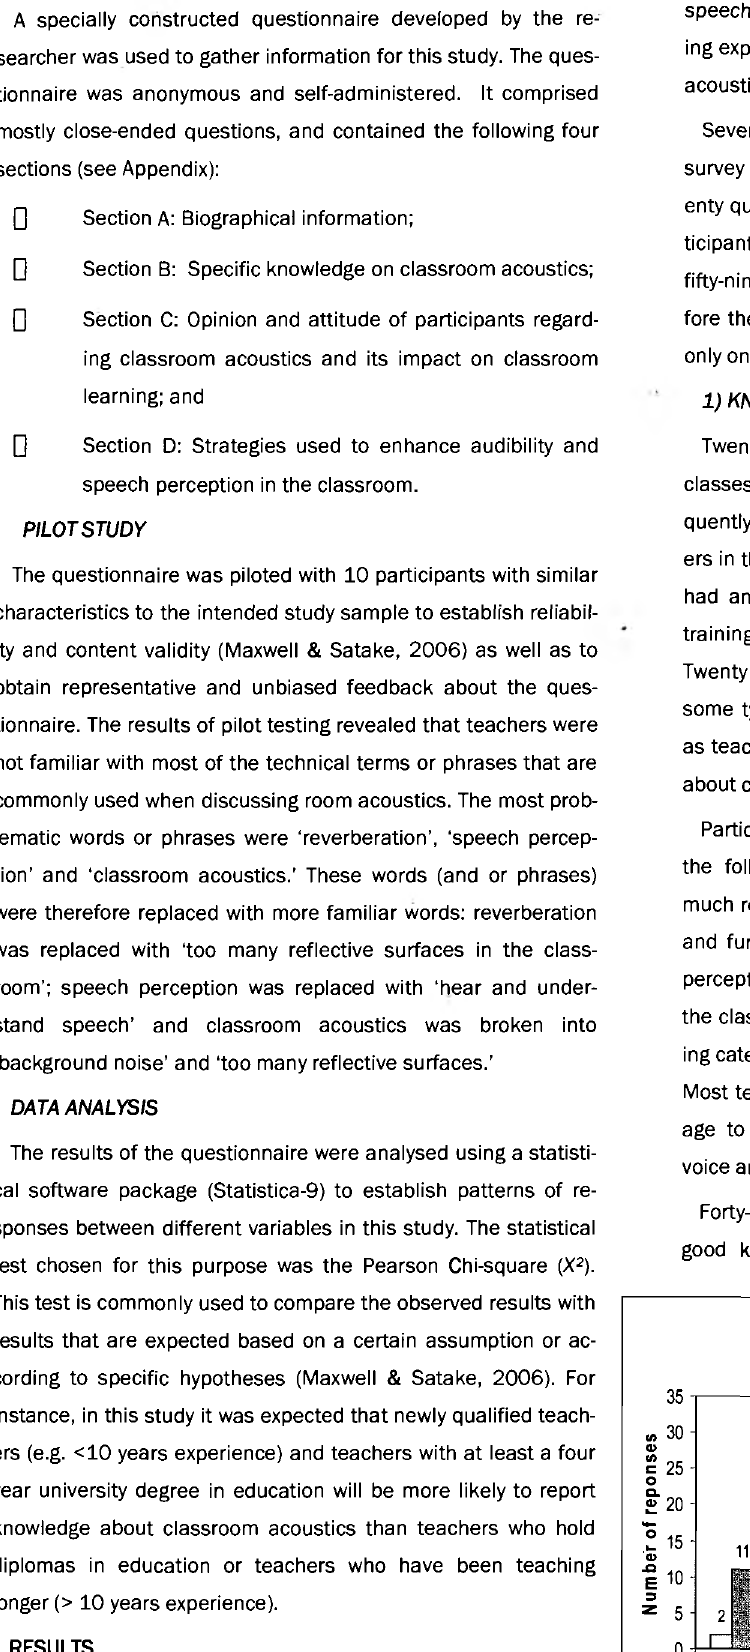
Figure 1: Teachers' self-rating of their own knowledge